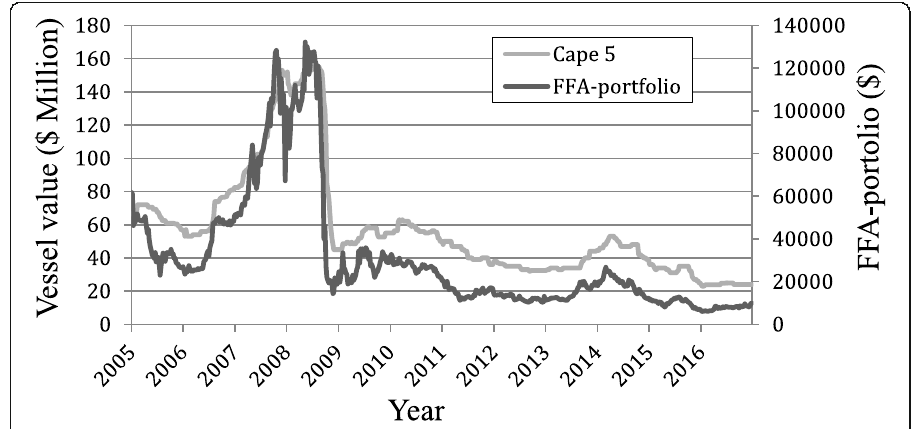
Fig. 1 Comparison between Capesize vessel price (5 yr old) and FFA portfolio. Source: Clarkson Research, Baltic Exchange, authors ’